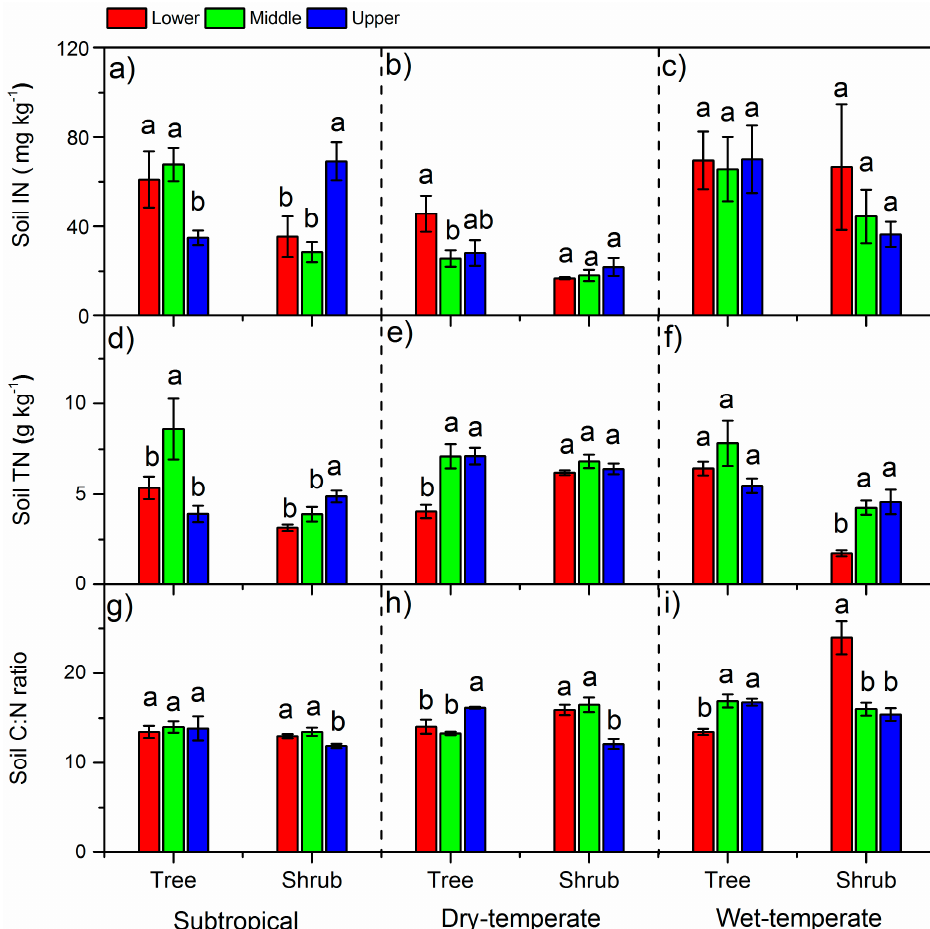
Figure 4. Soil IN, TN and C:N ratio under the canopy of trees and shrubs along the altitude in subtropical ( a , d , g ), dry-temperate ( b , e , h ) and wet-temperate mountain forest ( c , f , i ), lower case letters indicate the difference for the parameters between altitudes.